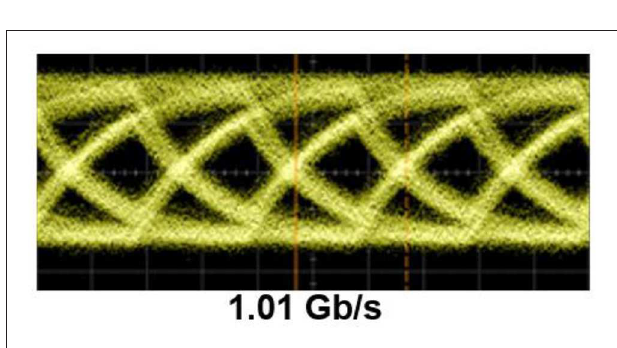
FIGURE 7 | Eye diagram of the 6.44% Sn